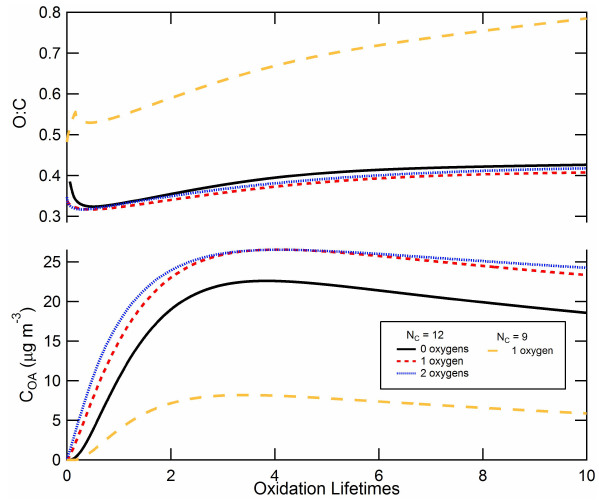
Fig. 14. The evolution of the calculated C OA (bottom) and O:C (top) with oxidation lifetime for a N C = 12 precursor species that contains 0, 1 or 2 oxygen atoms, or for a N C = 9 precursor that contains 1 oxygen